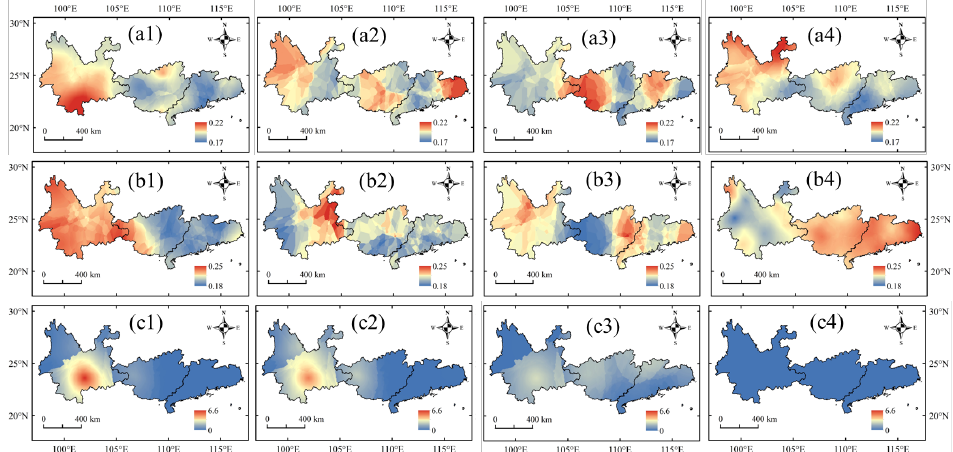
Figure 5. The intensities of drought ( a ), flood ( b ), and high temperature ( c ) during sugarcane growth stages in Guangdong, Guangxi, and Yunnan provinces. × and — in the boxes represent the mean and median values, respectively.